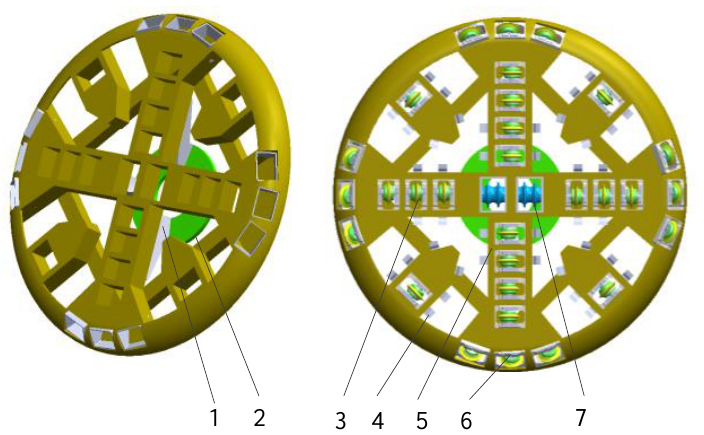
Figure 4. Model of shield cutterhead. 1-support; 2-flange; 3-normal disc cutter; 4-Scraper; 5-cutter beam; 6-gage disc cutter; 7-central disc cutter. Table 1. Cutterhead profile.